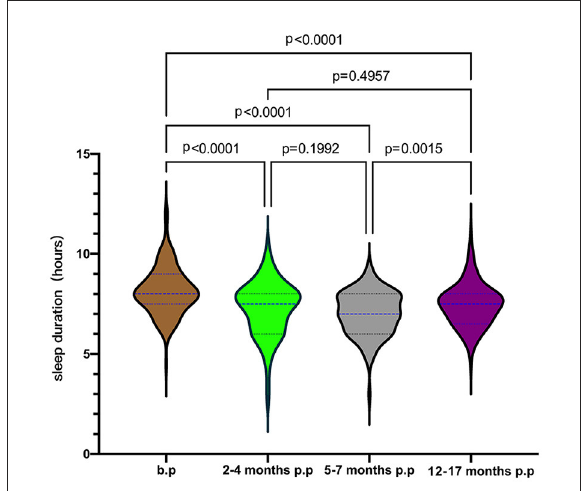
FIGURE2 Maternal sleep duration from pre-pregnancy to postpartum. b.p, before pregnancy; p.p,